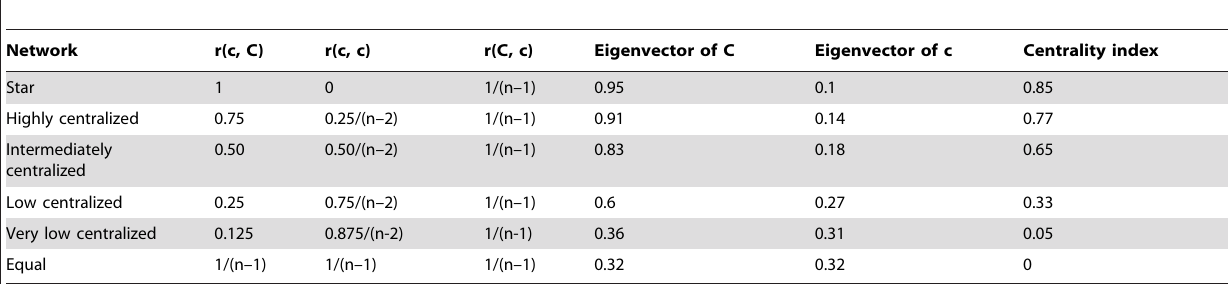
Table 1. Relationships, eigenvector centrality for the central individual C and the non central individuals c , and centrality index for each social